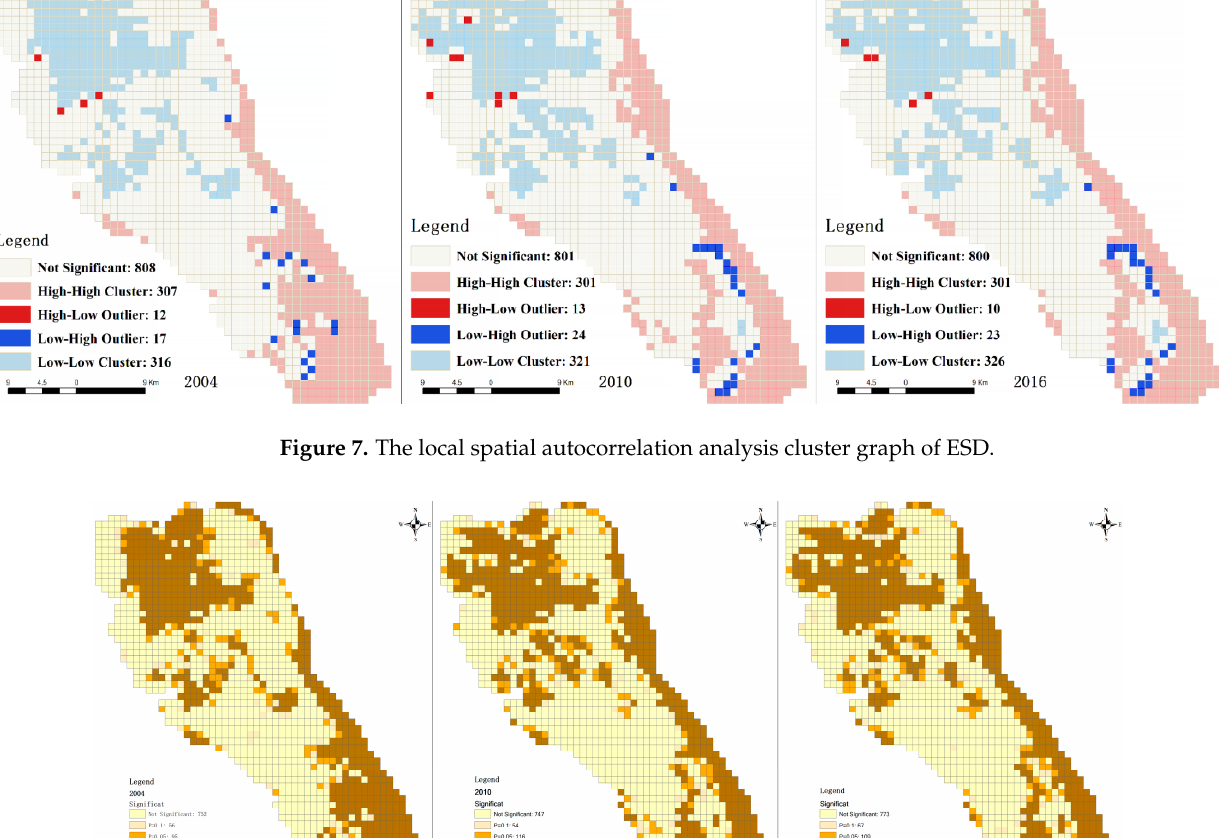
Figure 9. Impact of proportion of built-up area on ESD.4. The Application Practice in the NRIDB. The NRIDB is mainly composed of the Data Center, Computing Center, Service Cen- ter and Visual Web Front-End. It is a server-side + web-side GIS designed for the